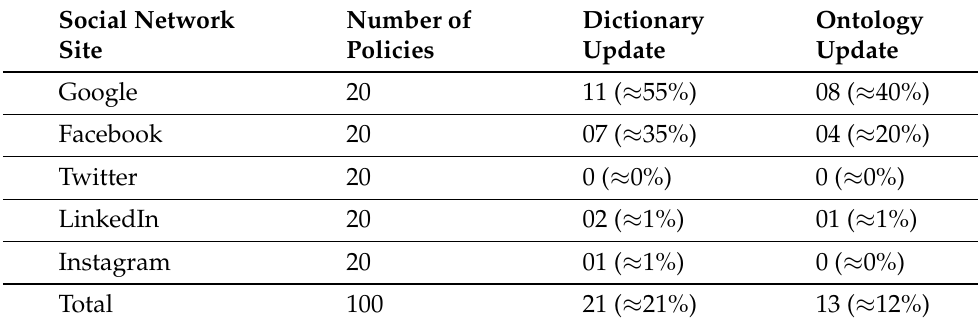
Table 3. Experimental results of social network data